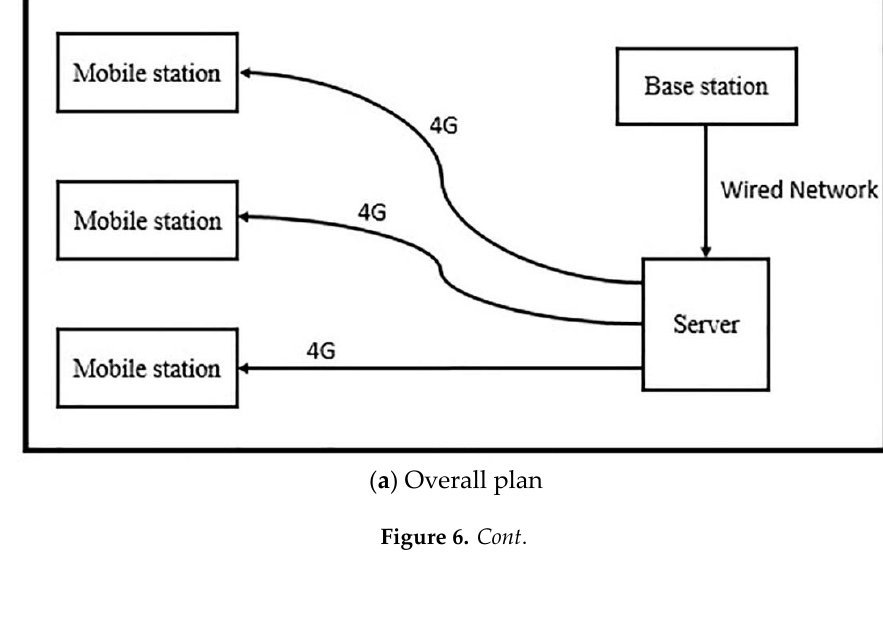
Table 3. Indicators of the WP-TD algorithm in different Gaussian white noise simulation